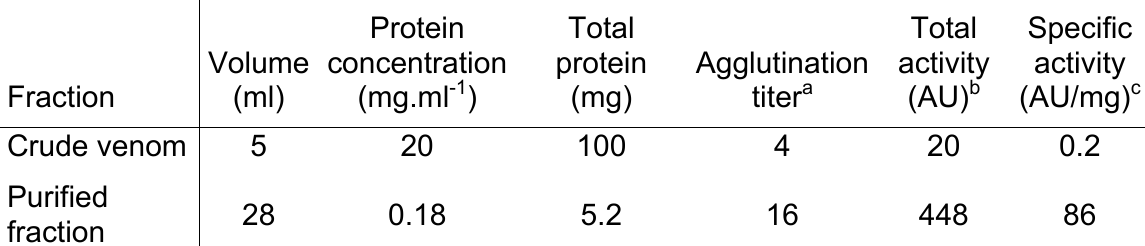
Table 1. Properties of the fractions obtained during lectin purification (from 100mg of crude